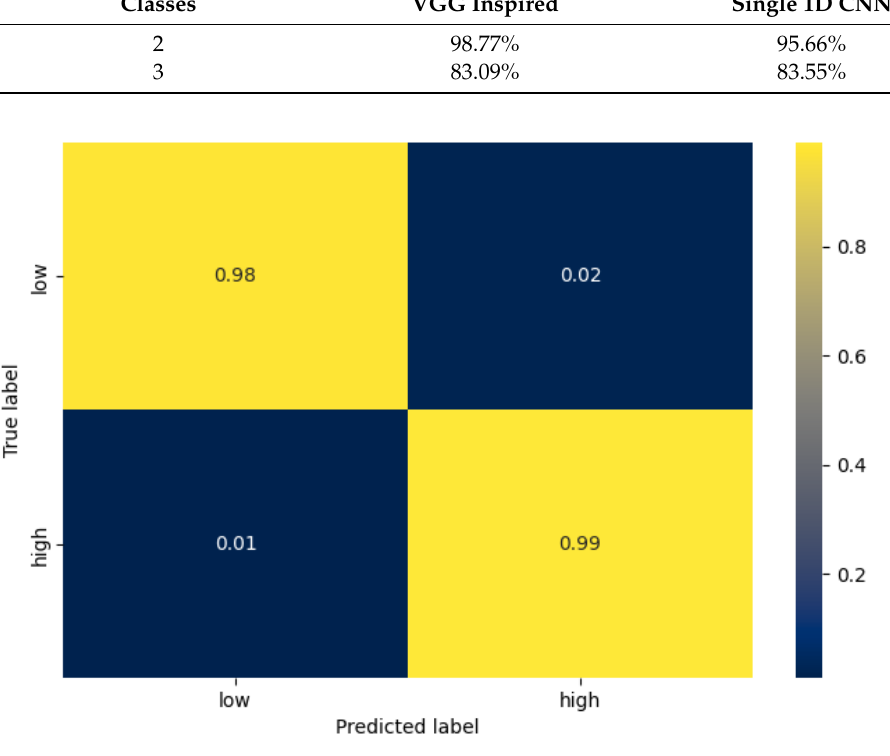
Figure 6. The confusion matrix of the best model for the stress detection task (VGG inspired